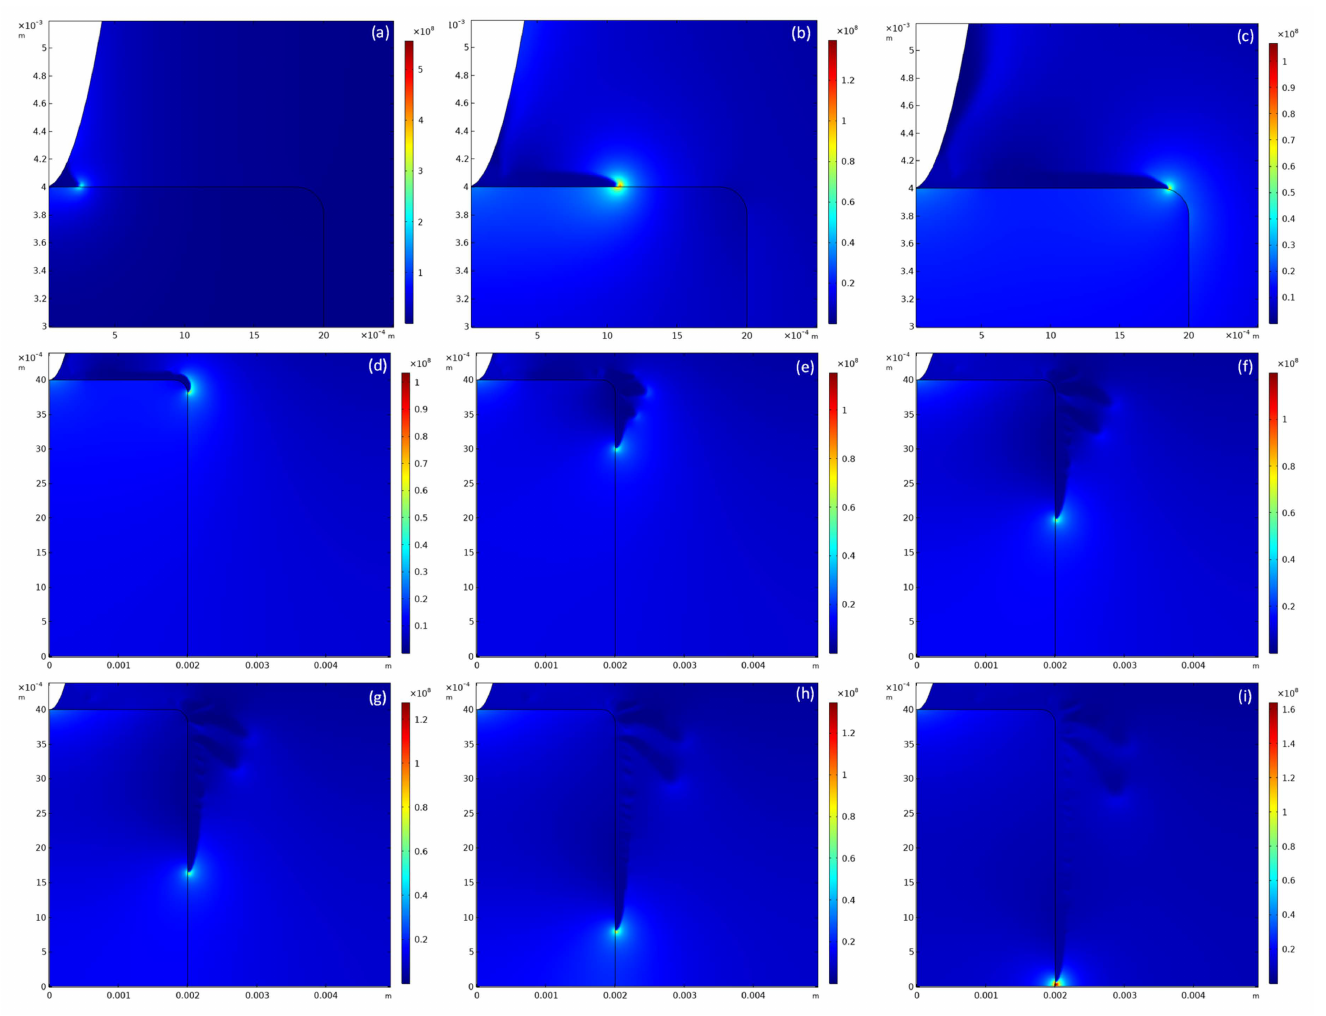
Figure 3. Surface discharge process: ( a ) 0.03 ns; ( b ) 0.2 ns; ( c ) 0.5 ns; ( d ) 0.7 ns; ( e ) 1.2 ns; ( f ) 1.7 ns;